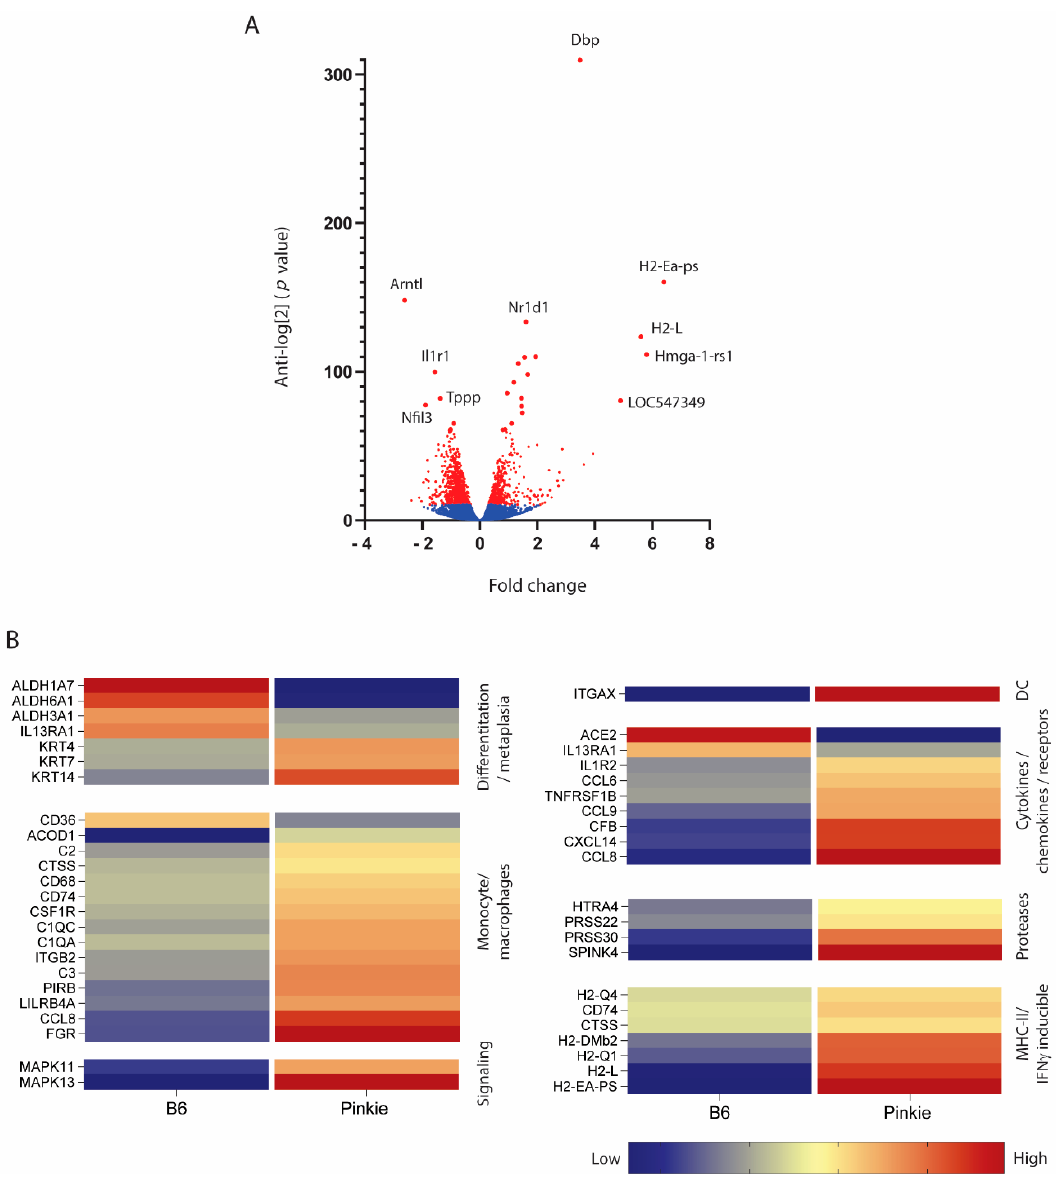
Figure 5. Differential gene expression from bulk RNA seq performed on C57BL/6 (B6) and Pinkie RXR- α mutant strains. ( A ) Volcano plot showing the up- and down-regulated genes in the conjunctiva of Pinkie compared with B6 control. Genes not reaching a significant difference and that did not pass the Benjamini–Hochberg procedure are shown in blue. Genes with significant between group difference are shown in red. ( B ) Heatmap of differentially expressed genes clustered into groups based on Gene Set Co-expression Analysis (GSCA) pathways. All the genes passed the Benjamini–Hochberg procedure to exclude false discovery; the selected genes had a p -value > 0.0006. Each row represents a specific gene: the right column represents the Pinkie strain and left column represents the B6 strain. Red colors indicate higher expression while blue colors indicate lower expression.